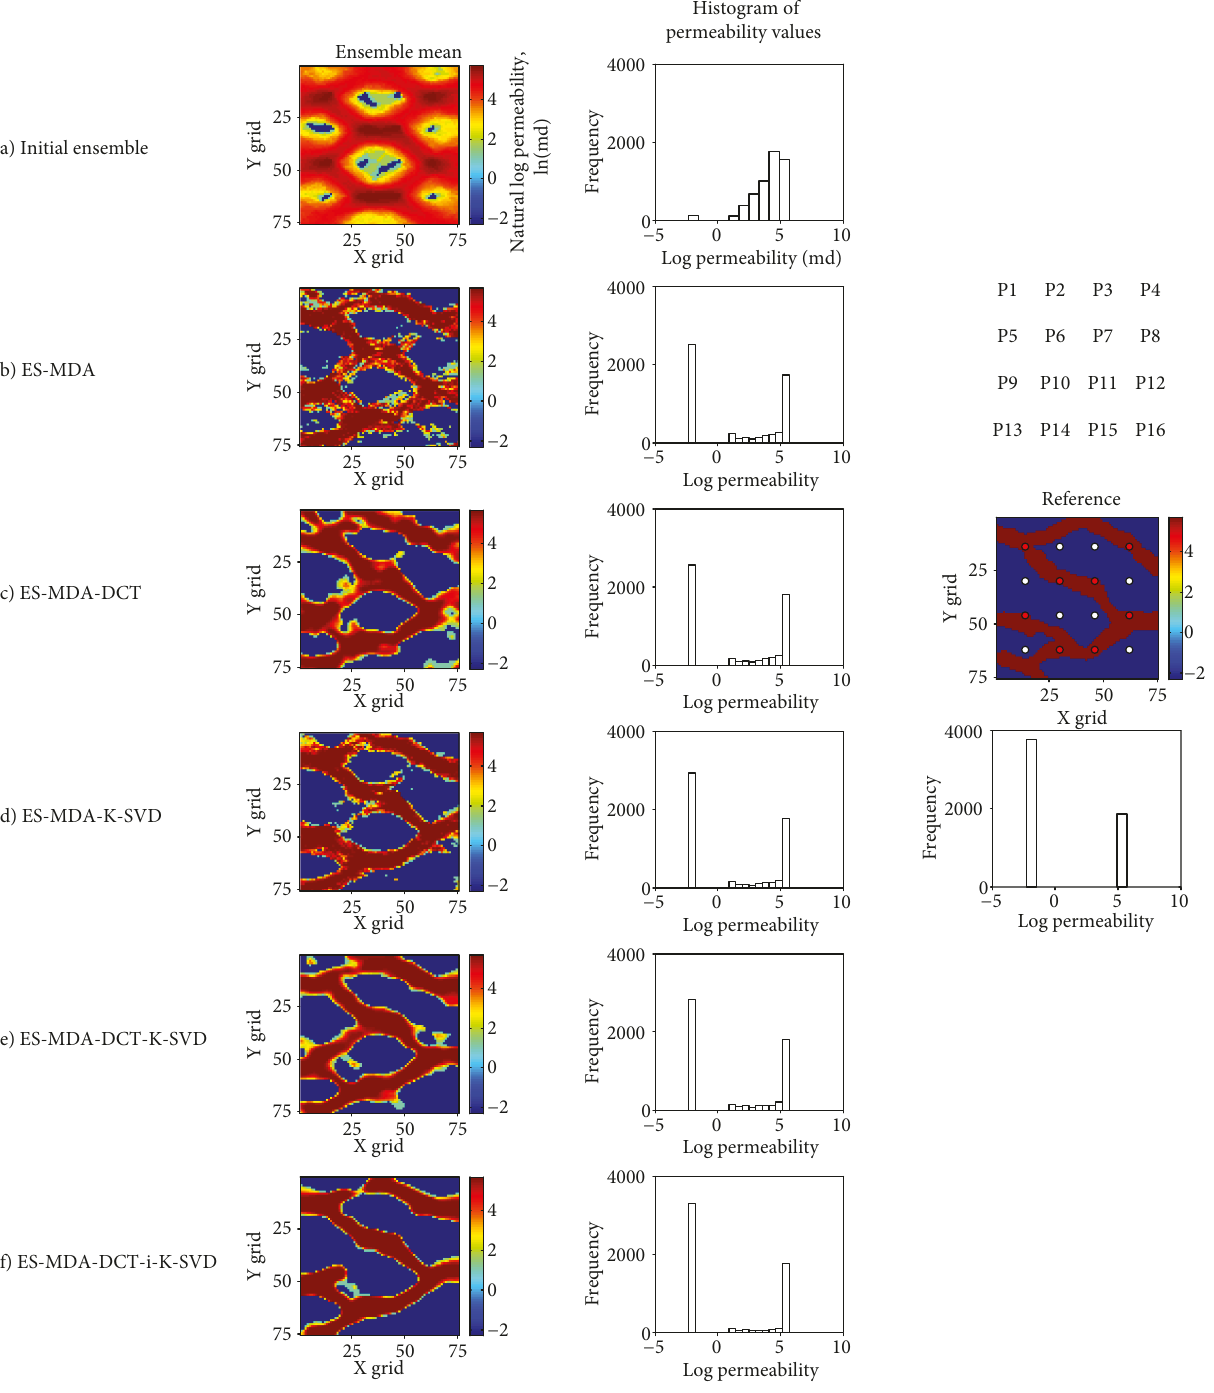
Figure 10: Permeability distribution of the ensemble means and their histogram of permeabilities obtained after history matching of Case